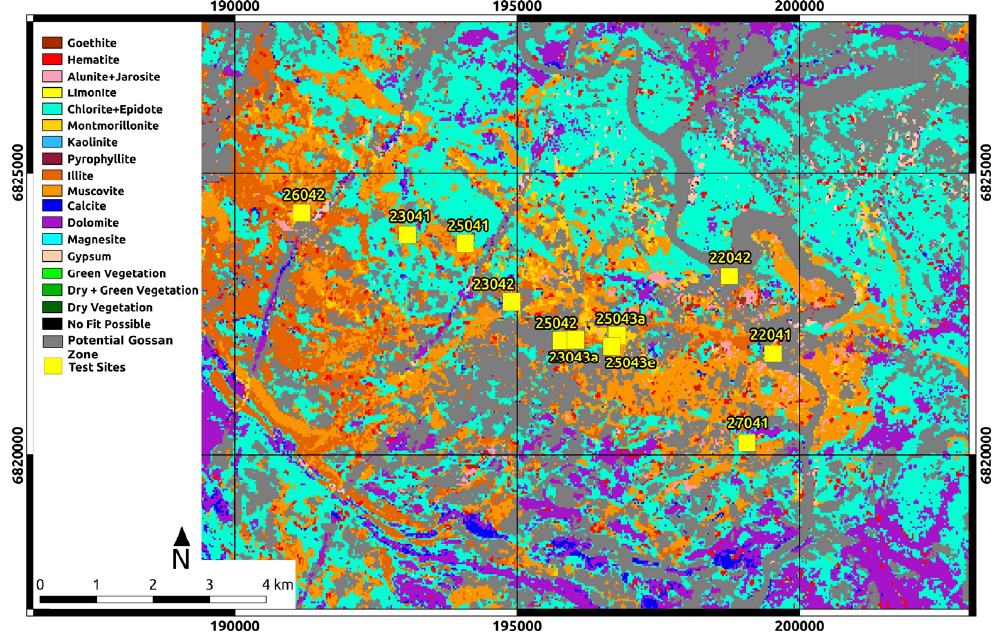
Figure 19. Location of the gossan zones, shown as grey opaque overlay, calculated from simulated EnMAP data.